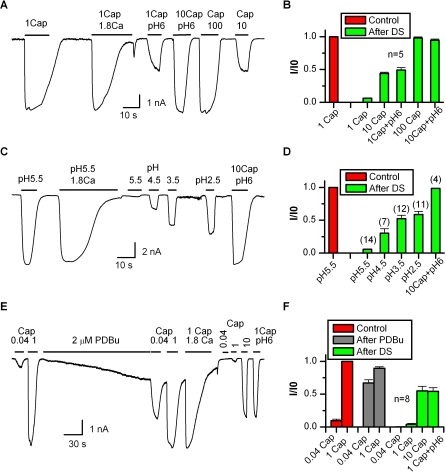
Adaptation of TRPV1 in General(A) Whole-cell recording from native TRPV1 in cultured DRG neurons. After desensitization by application of 1 μM capsaicin plus 1.8 mM Ca2+, the native channels became only partially responsive to 10 μM capsaicin or 1 μM capsicin plus pH 6, but were fully activated by 100 μM capsaicin or 10 μM capsaicin plus pH 6. Ca2+-free bath solution was used.(B) Quantification of peak currents for recordings in (A).(C) Adaptation of low pH responses. The current evoked by low pH was fully desensitized in the presence of Ca2+ (1.8 mM). The channel became subsequently irresponsive to pH 5.5, but remained activated with further acidification or combined application of low pH and capsaicin.(D) Comparison of proton responses before and after desensitization.(E) Whole-cell recording from a phosphorylated and subsequently desensitized channel. The phosphorylation of the channel was induced by continuous local perfusion with 2 μM PDBu for ∼5 min (2 mM MgATP in pipette). The state of the phosphorylation was verified with two capsaicin concentrations, 0.04 and 1 μM, applied before and after the treatment. The application of PDBu caused a down-drift of the baseline and a large increase in the 0.04 μM capsaicin response. After phosphorylation, 1 μM capsaicin with 1.8 mM Ca2+ was applied to desensitize the channel, and the responsiveness of the desensitized channel was subsequently examined with three conditions, 1 μM capsaicin, 10 μM capsaicin, and 1 μM capsaicin plus pH 6.(F) Average plot of peak currents. The desensitization reduced the peak response by ∼95% for 1 μM capsaicin and nearly half for 10 μM capsaicin or 1 μM capsaicin plus pH 6. These changes were similar to those of nonsensitized channels. Recordings were from HEK293 cells for (C–F). V
h = −60 mV in all cases.